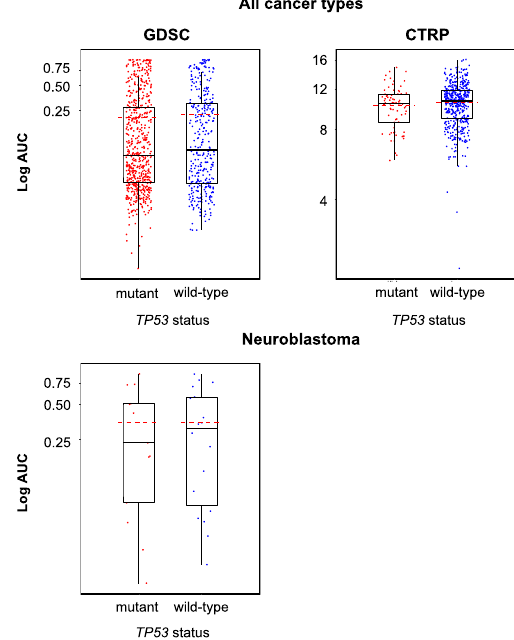
Figure 2. YM155 sensitivity in TP53 wild-type and TP53 mutant cancer cell lines based on the analysis of GDSC and CTRP data, both determined across all investigated cancer types / cell lines (GDSC, p = 0.458; CTRP, p = 0.216) and in a neuroblastoma-specific analysis (GDSC, p = 0.922; all 12 neuroblastoma cell lines in the CTRP harbor wild-type TP53 ). The comparisons did not reveal significant di ff